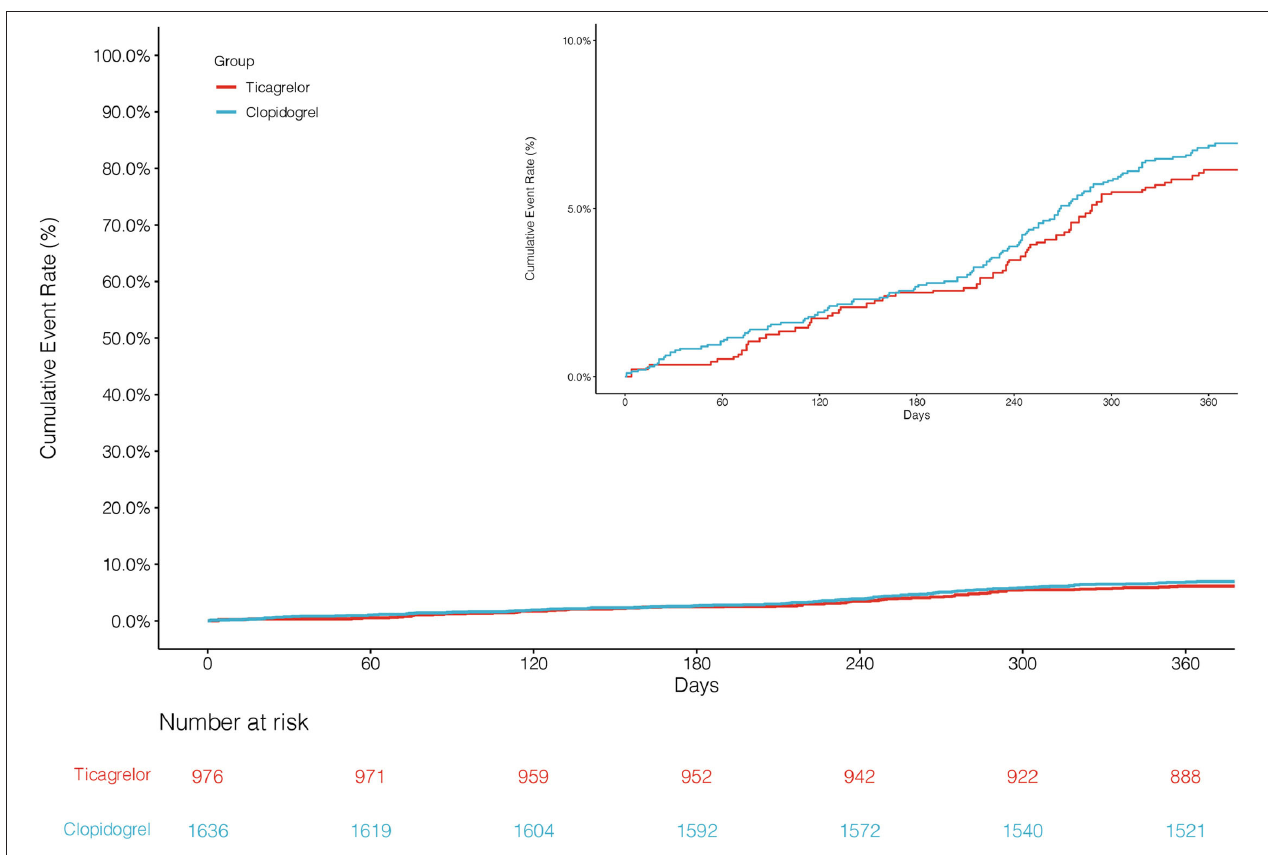
FIGURE 3 | Cumulative incidence of MACCEs after inverse probability of treatment